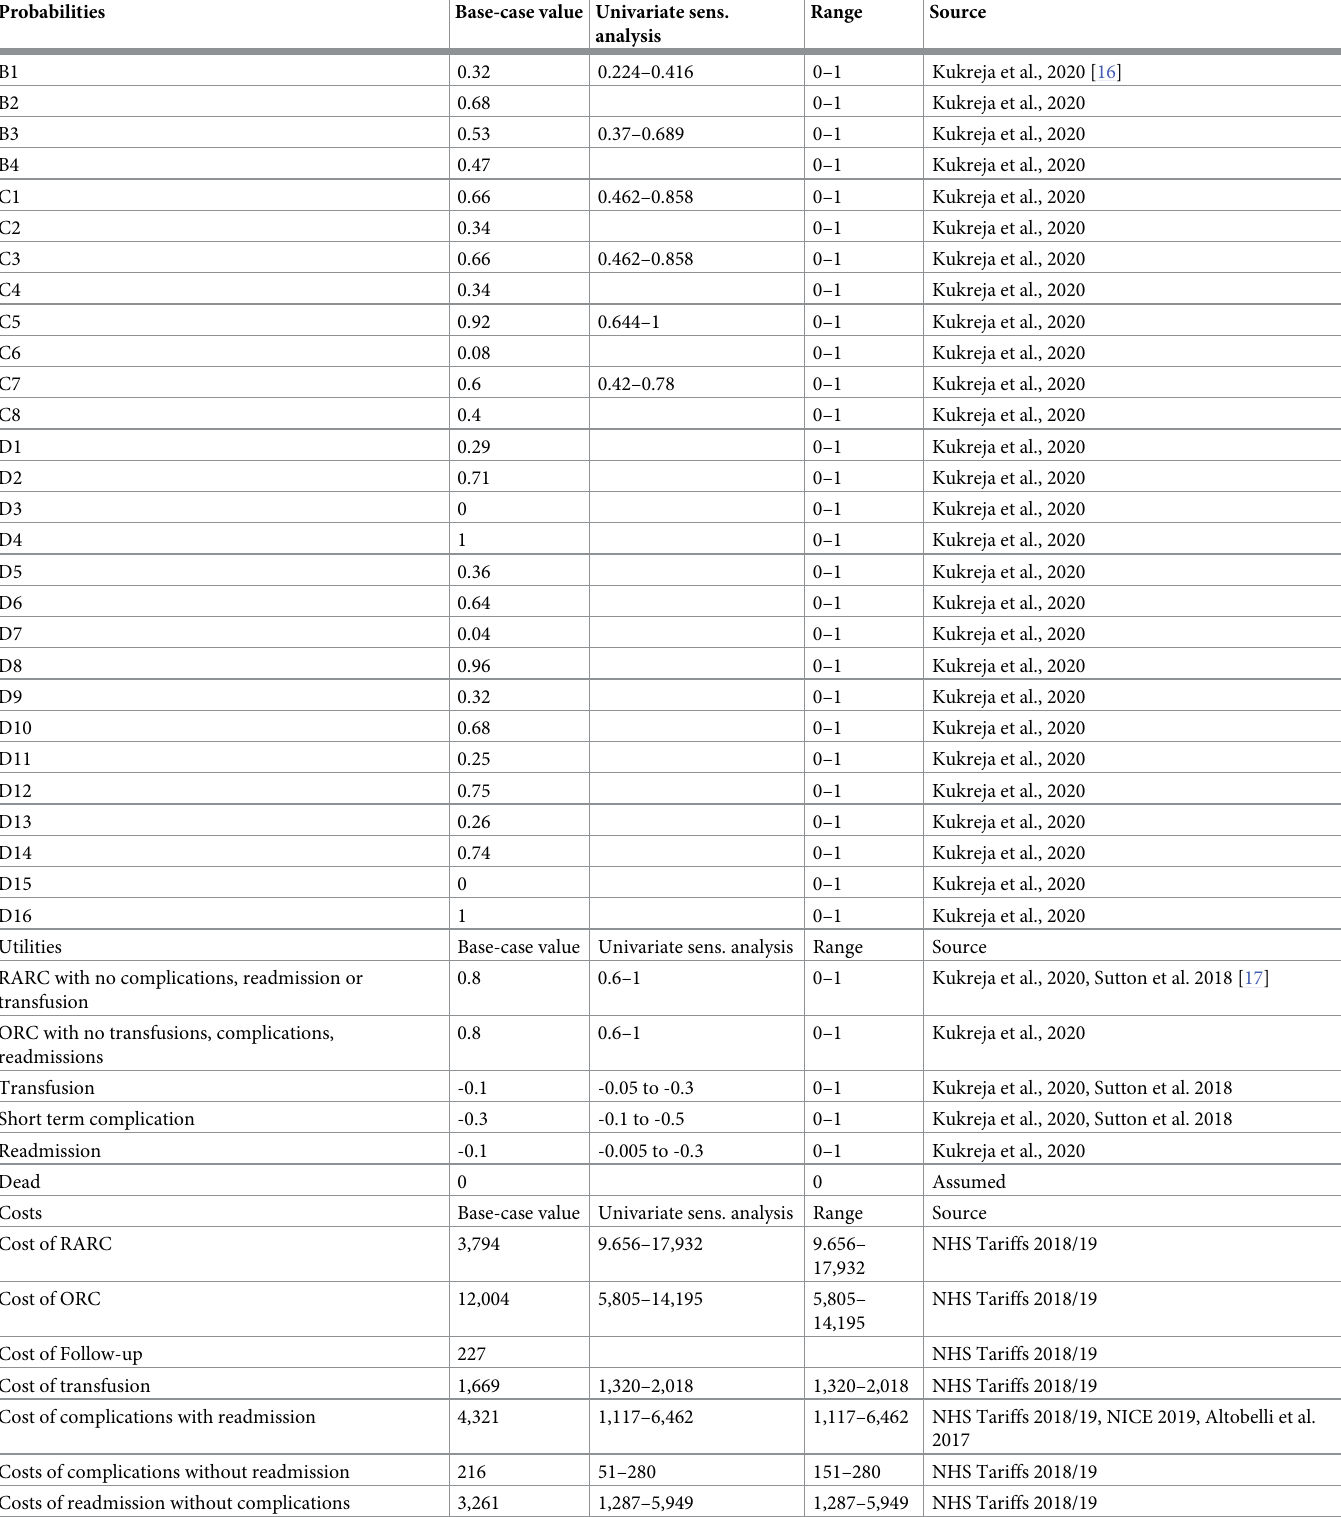
Table 1. Model parameters and range of values for sensitivity analysis: Utilities scores, costs, and